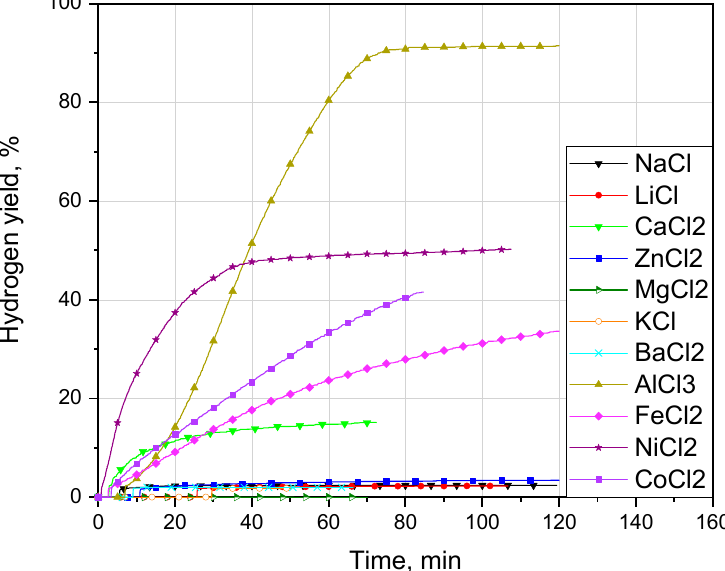
Figure 2. Hydrogen yield kinetic curves for different solution compositions.